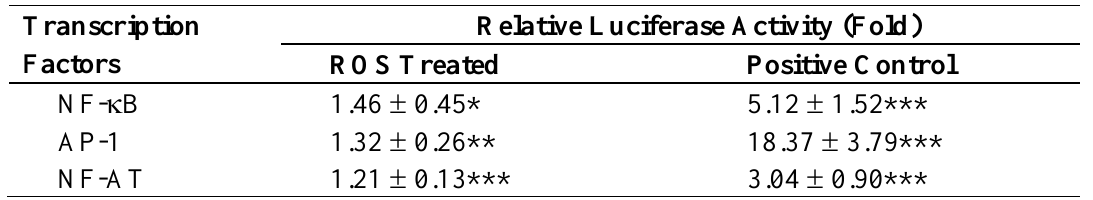
Table 1. Effects of ROS on activities of TFs, NF-κB, AP-1 and NF-AT. The data are expressed as fold change in luciferase activity of cells treated with 100 μM H untreated cells. Cells at a density of 1 × 10 5 cells/well were treated with 100 μM H 6 h. For positive control, cells were treated with 20 ng/mL of TNF-α (for NF-κB), 20 ng/mL of PMA (for AP-1), or 10 ng/mL of PMA and 1 μg/mL of ionomycin (for NF-AT) for 6 h. After the stimulation, harvested cells were used for luciferase assay as described in Materials and Methods. *P < 0.05, **P < 0.01, ***P < 0.005.